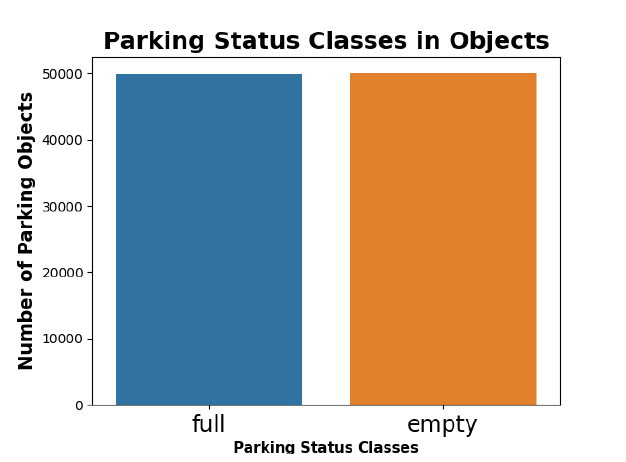
Figure 8. Parking Status Types.